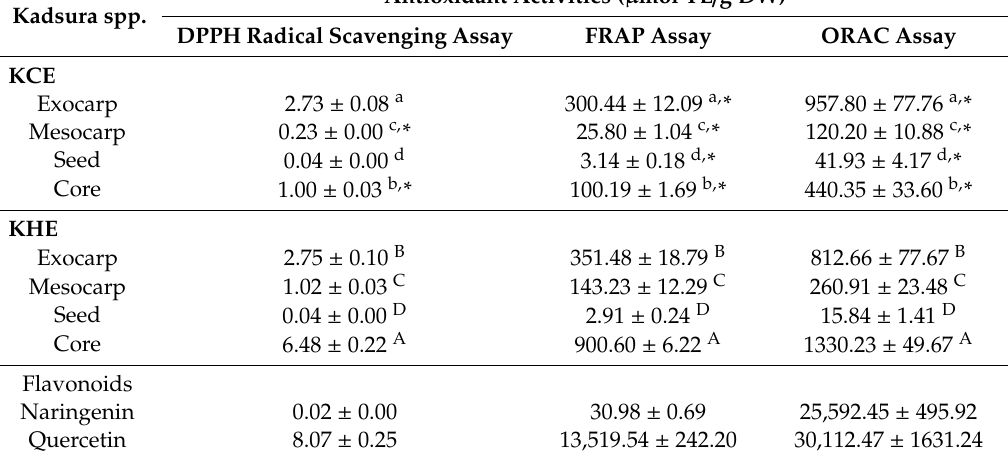
Table 5. Antioxidant activities in the di ff erent fruit parts of Kadsura coccinea (Lem.) A.C. Sm. extract (KCE) and Kadsura heteroclita (Roxb.) Craib extract (KHE) and their detected flavonoids, naringenin and quercetin. Kadsura